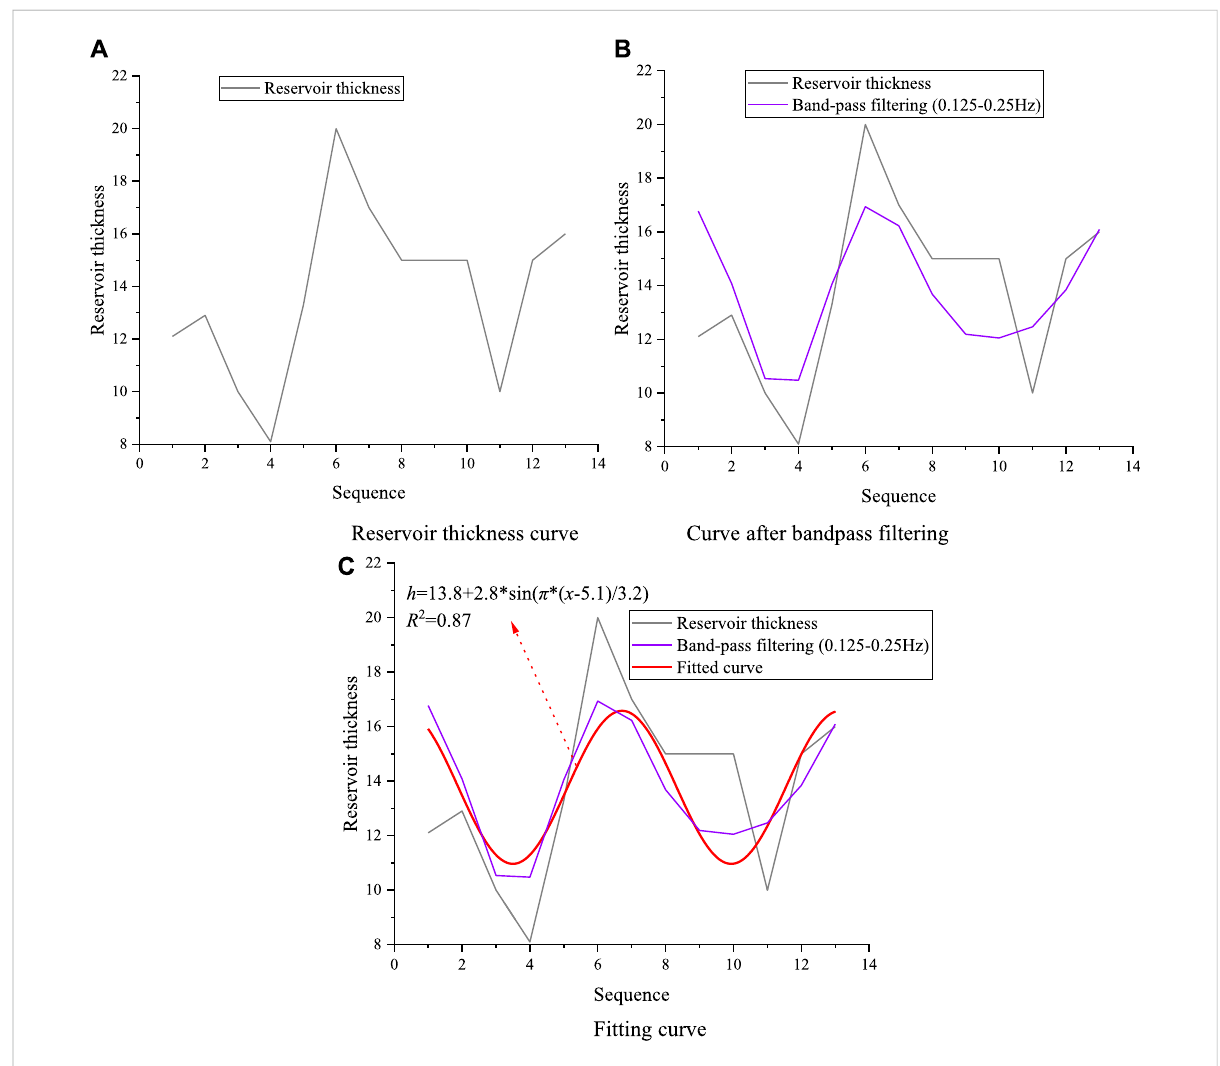
FIGURE 6 Reservoir thickness curve processing. ( A) Reservoir thickness curve (B) Curve after bandpass fi ltering. (C) Fitting